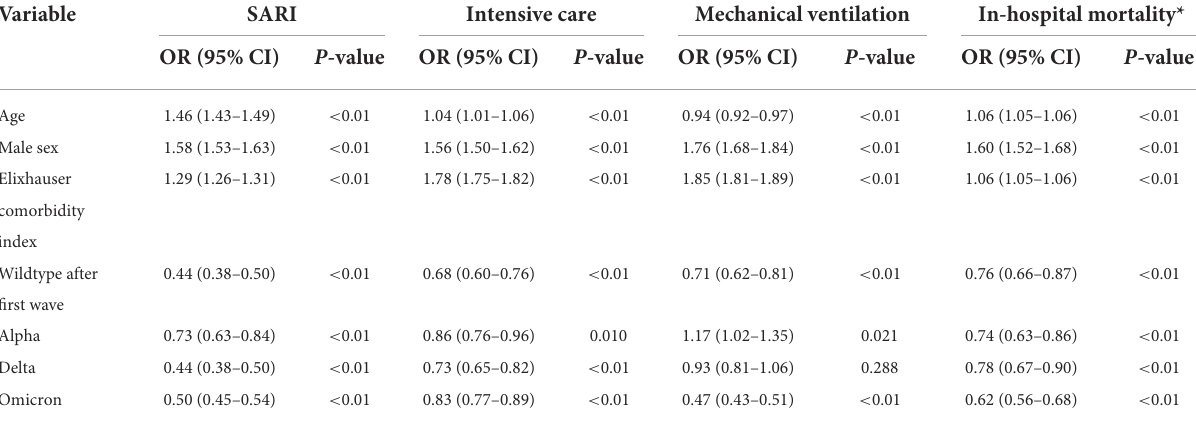
TABLE 2 Multivariable analysis for occurrence of SARI and in-hospital